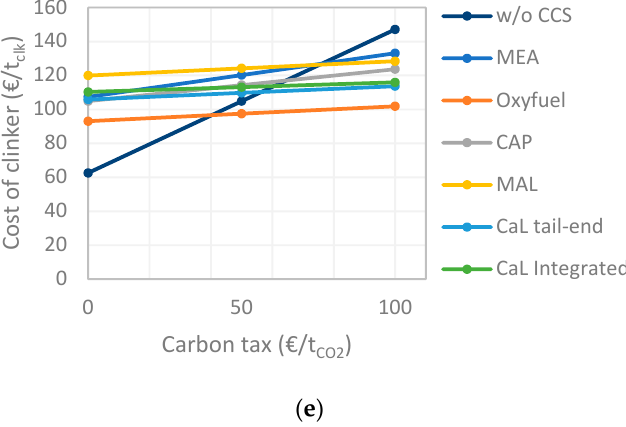
Figure 6. Sensitivity of the cost of CO 2 avoided to the ( a ) coal price, ( b ) cost of steam, ( c ) cost of electricity and ( d ) a change in CAPEX, and ( e ) sensitivity of the cost of clinker to a carbon tax.